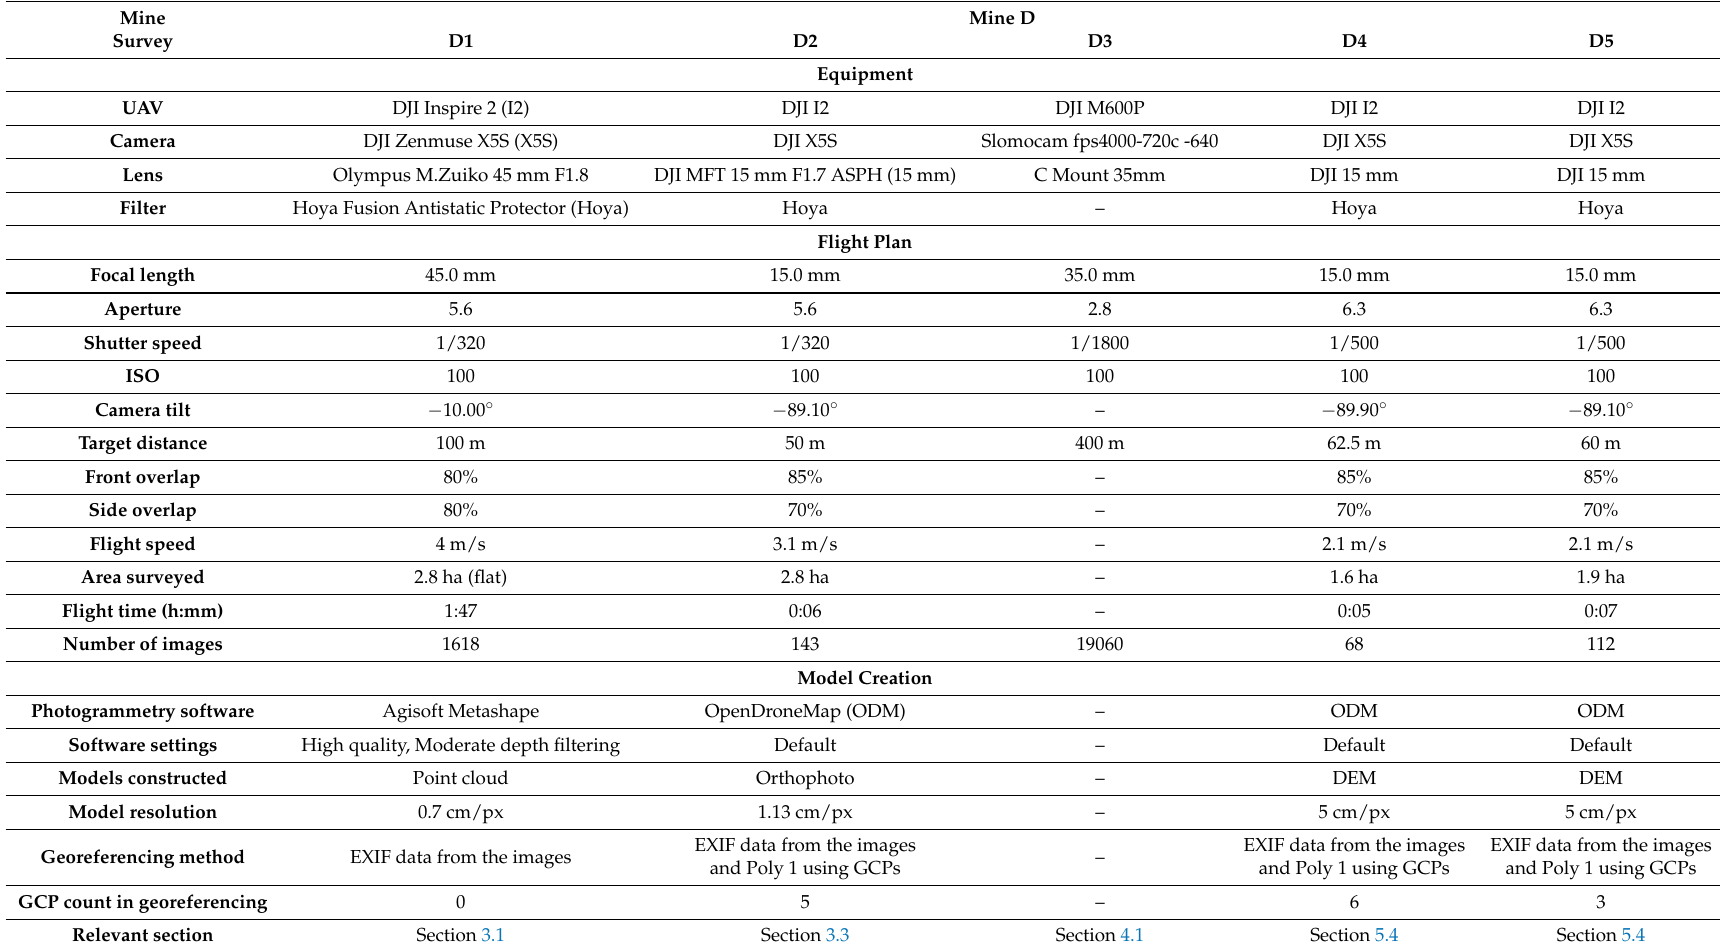
Table A4. Workflow for Mine